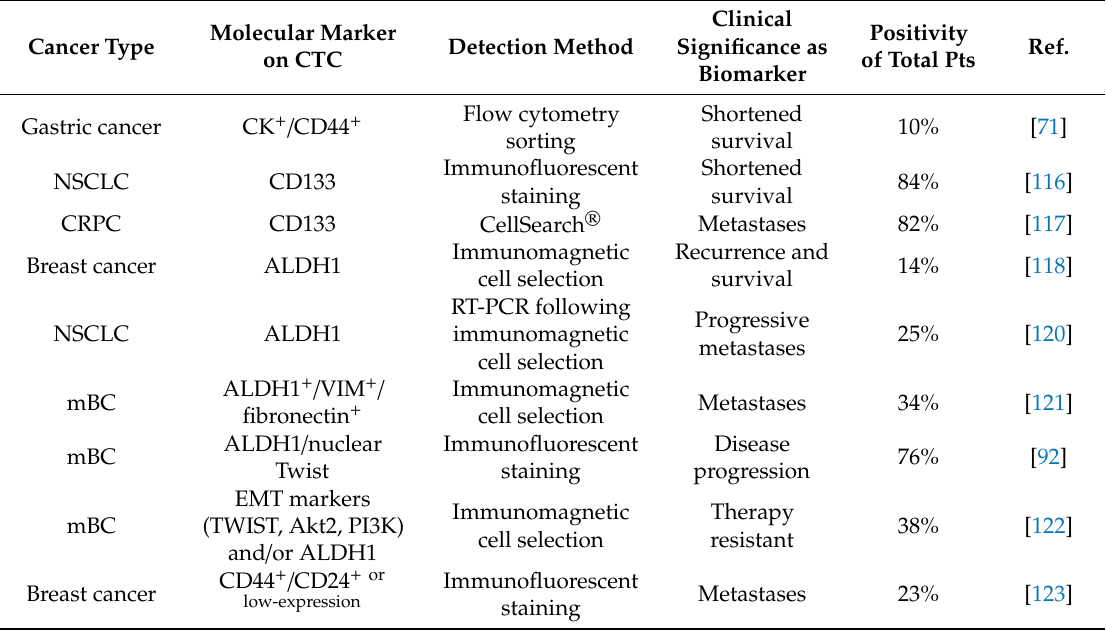
Table 2. Circulating cancer stem cell (CTSC) markers from di ff erent tumor types and clinical significance as surrogate